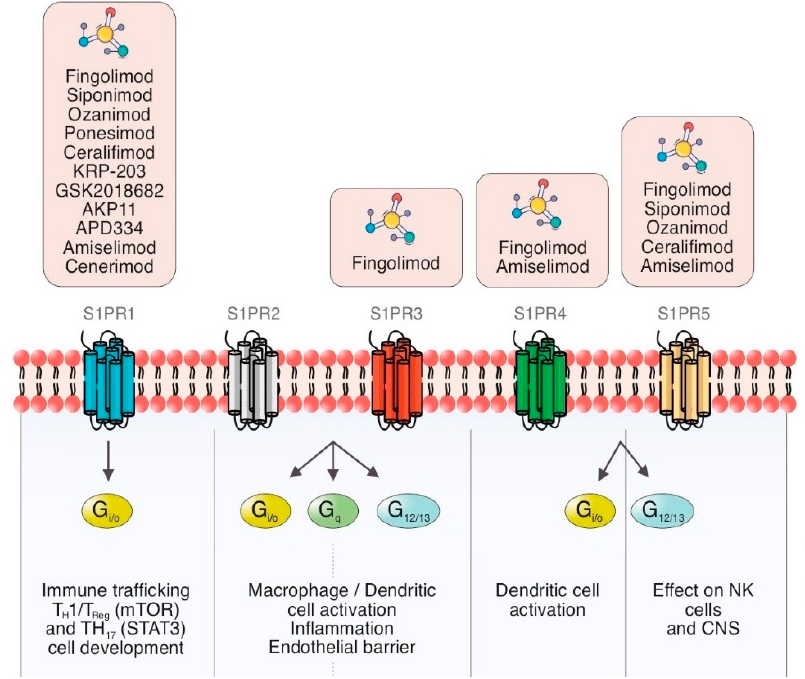
Figure 1. Schematic summary of the current view of S1PR modulators and S1P signaling pathways with cellular therapeutic targets in inflammation and immune processes through different G pro- teins.